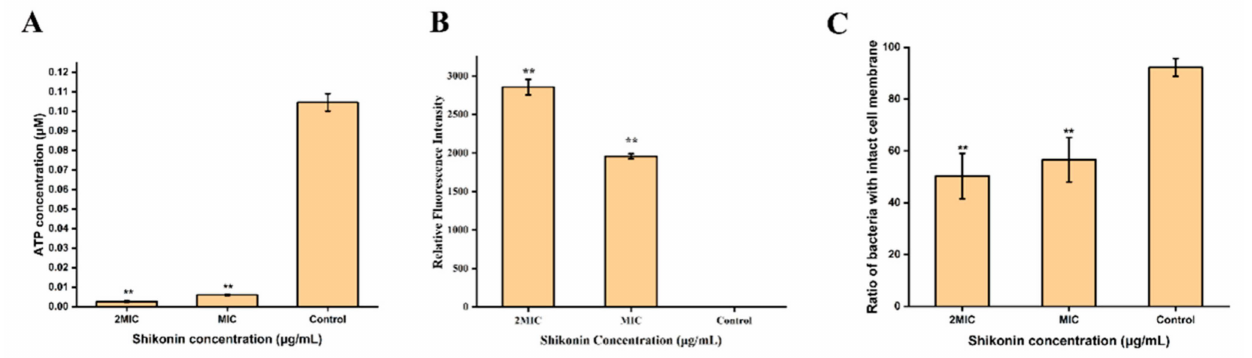
Figure 2. The effect of shikonin on the intracellular ATP concentration ( A ), cell membrane potential ( B ), cell membrane integrity ( C ) of strain ATCC29213. The average and standard deviation of three independent experiments were presented in a histogram. ** p < 0.01.